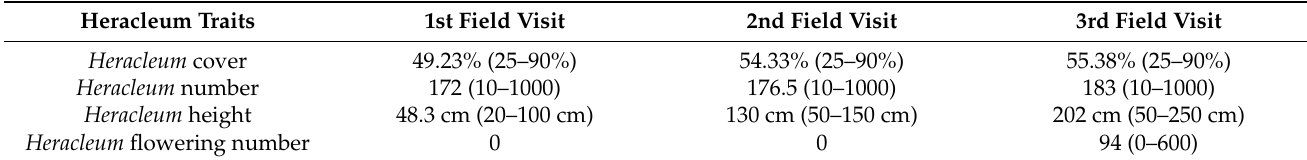
Table 1. Caucasian hogweeds’ average traits for each field inspection separately, determined within a 50 m radius circle plots; the ranges of recorded measurements on 52 plots are given in brackets.